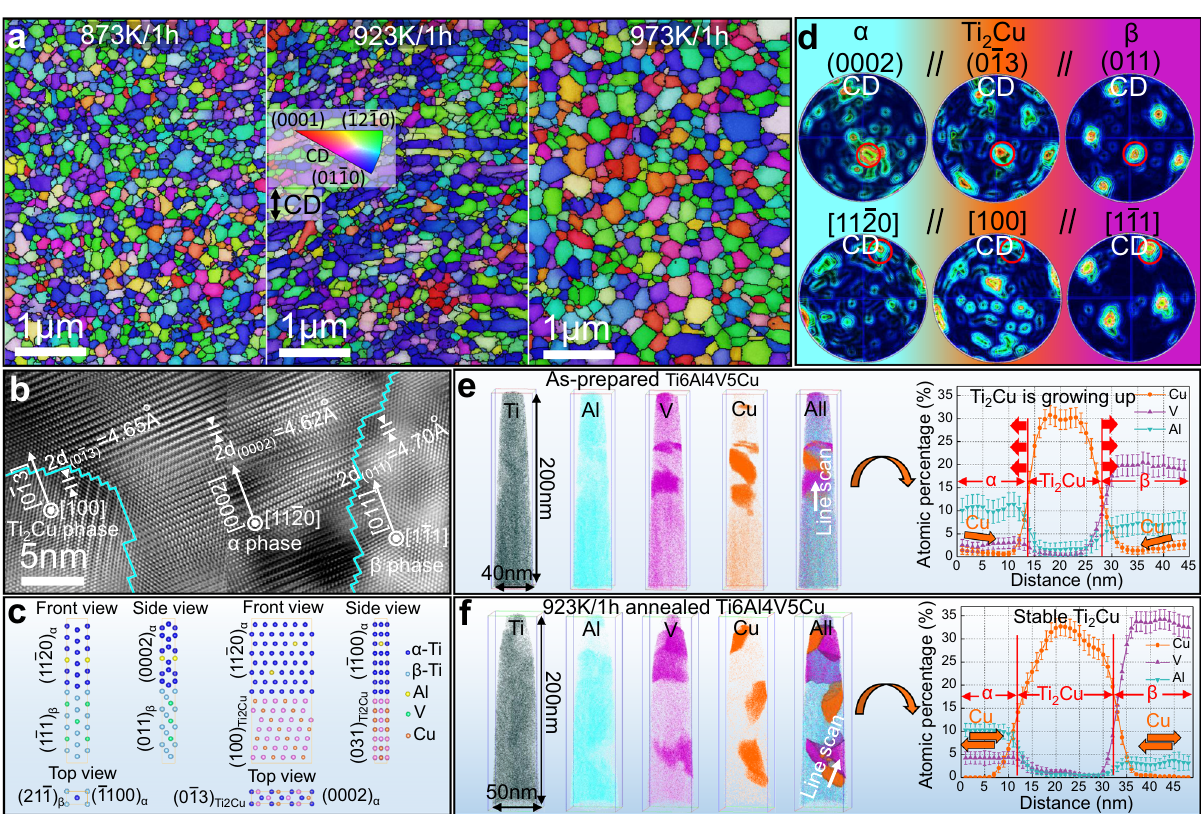
Fig. 3 The DPHS nanostructure is stabilized thermodynamically and kinetically. a IPF maps of the Ti6Al4V5Cu sample annealed at various temperatures, only the IPF maps of α phase is shown for brevity, compressive direction (CD) is denoted in the fi gure. b High-resolution TEM observation showing a low mis fi t orientation relationship of α /Ti 2 Cu/ β phases. c Interfacial structural models for fi rst principles calculations. d Pole fi gures of the Ti6Al4V5Cu sample annealed at 973 K, the initial low-energy orientation relationship was retained. e Atom probe tomography (APT) analysis in the as-prepared Ti6Al4V5Cu sample, the copper concentration gradient indicating that the Ti 2 Cu/ β shell can be formed rapidly. f APT analysis of the 923 K/1 h annealed Ti6Al4V5Cu sample. Error bars in e and f indicate standard deviations of measured Al, V, Cu